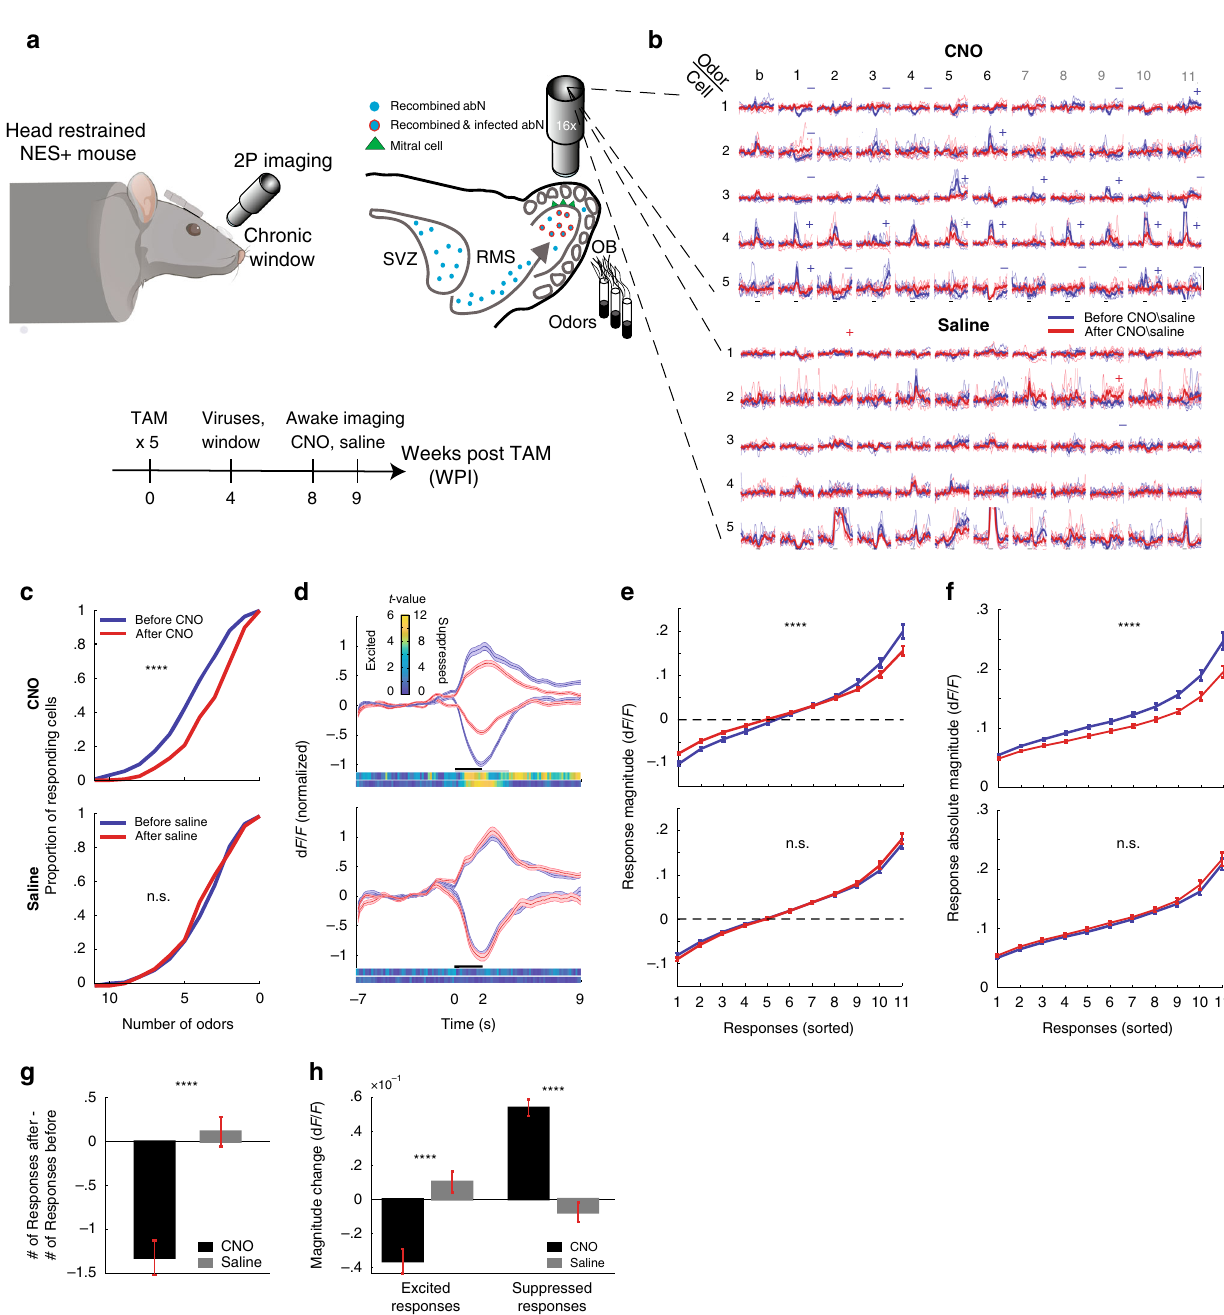
Fig. 3 Silencing abGCs quenches odor-evoked responses in MCs (awake mice). a Schematic illustration of the setup, experiment, and timeline. b Examples of odor-evoked calcium transients for ten different neurons from the same mouse. All symbols are the same as in Fig. 2e, g, with the addition that minus signs denote signi fi cant differences among suppressed responses. c Cumulative distribution of the proportion of MCs responding to 0 – 11 odors, before (blue) and after (red) CNO (top) or saline (bottom) (CNO: N = 5 mice, n = 170 cells, p < 0.0001; Saline: N = 5 mice, n = 152 cells, p = 0.62, Kolmogorov – Smirnov tests). d Traces of the average ± SEM calcium responses to odor stimulation before and after CNO or saline administration. Suppressed (CNO: 404 cell-odor pairs, Saline: 251 cell-odor pairs) and excited (CNO: 531 cell-odor pairs, saline: 522 cell-odor pairs) responses are shown separately. Upper colored bar (excited responses, range: 0 – 6) and lower colored bar (suppressed responses, range: 0 – 12) are t values between the before- after distributions as a function of time. e Response magnitude in ranked order for all cell-odor pairs showing quenching of both suppressed (negative values) and excited (positive values) responses. (CNO: n = 170 cells, p << 0.0001; saline: n = 152 cells, p = 0.07, Wilcoxon signed rank tests on cells curves ’ standard deviations before vs. after CNO). f Response magnitude in ranked order, in absolute values to account for both excited and suppressed responses equally. The values before injection are reduced after CNO but not after saline injection (CNO: p << 0.0001; saline: p = 0.83, Wilcoxon signed rank tests on cells curves ’ standard deviations before vs. after CNO). g Quantitative analysis of the difference in responsiveness (number of responses) due to CNO vs. saline. ( n = total 322 cells, p << 0.0001, unpaired t -test). h Quantitative analysis of the difference in response magnitude due to CNO vs. saline injections. Suppressed and excited responses are shown separately. n excited = 1053 cell-odor pairs, p << 0.0001, n suppressed = 655 cell-odor pairs, p << 0.0001, unpaired t -tests). CNO condition: N = 5 mice; saline condition: N = 5 mice, for all comparisons described in this fi gure. Statistical tests are two- sided, and error bars are SEMs. a was created with